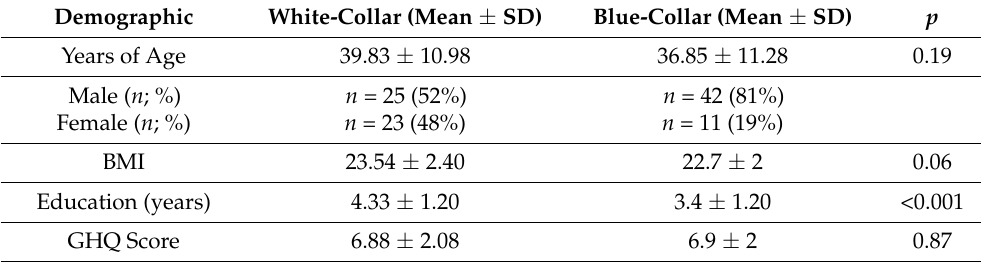
Table 1. Compilation of the demographic variables of the blue and white-collar sample groups.